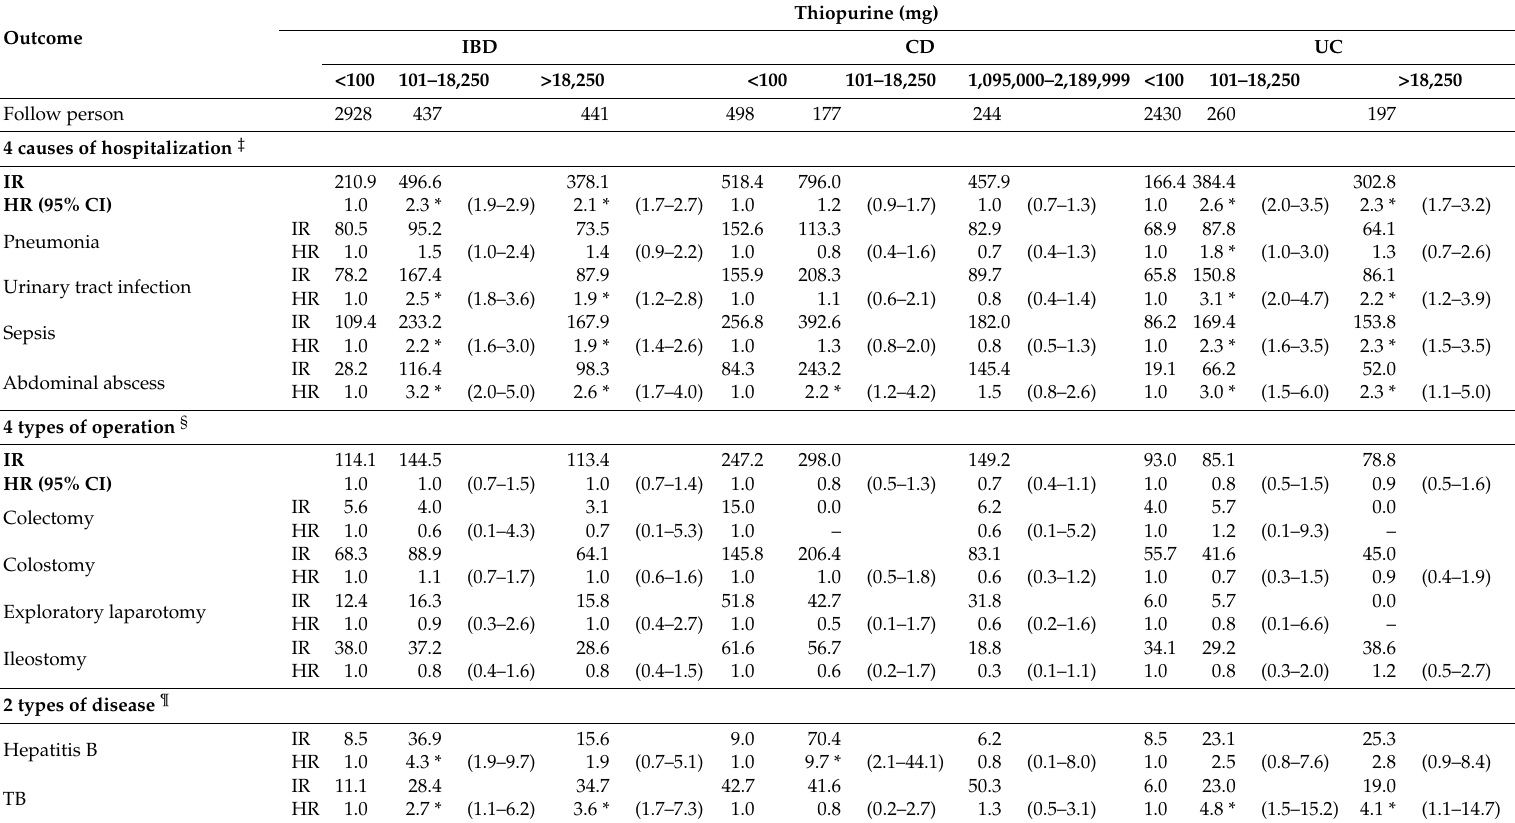
Table 3. Risks of operation, hospitalization, and related diseases associated with thiopurine therapy among patients with IBD in Taiwan, 2001–2015.